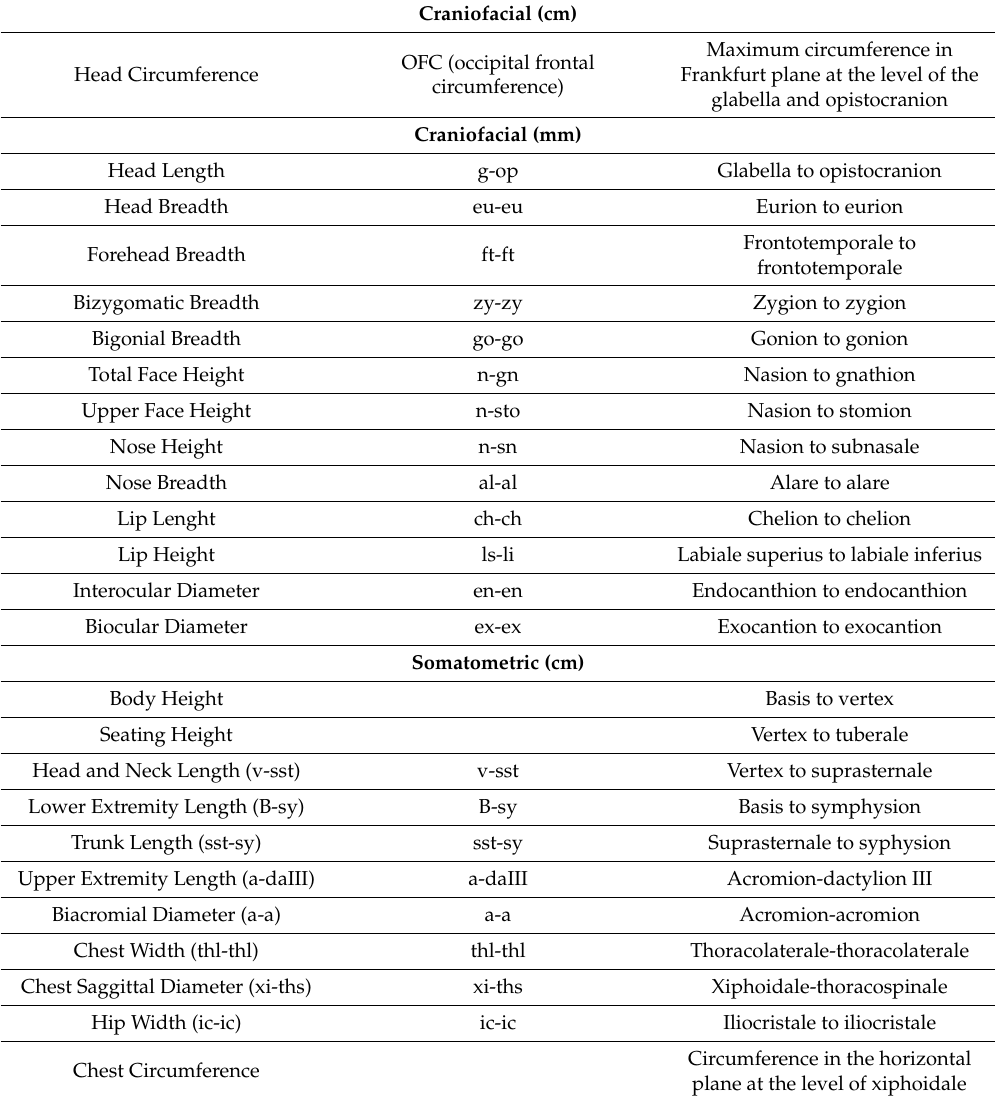
Table 1. Anthropometric measurements employed in this